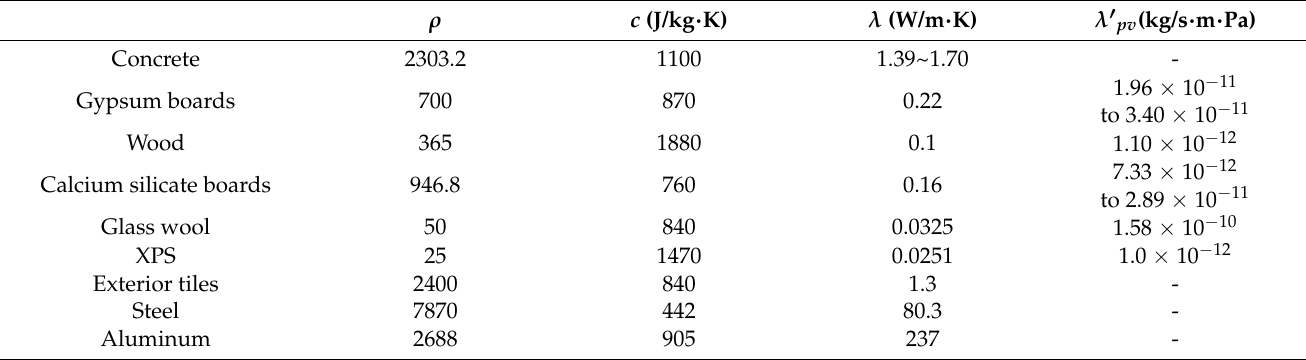
Figure 6. Moisture isotherms of materials. Table 4. Hygrothermal properties and densities of materials.